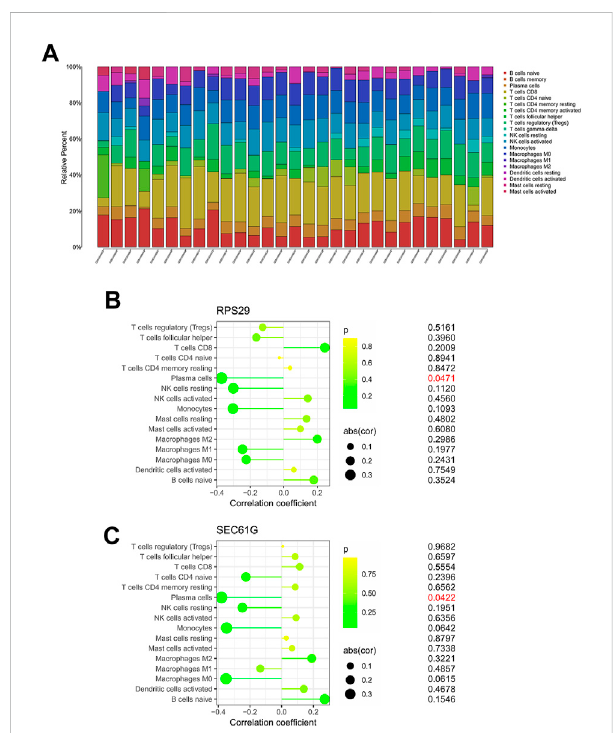
FIGURE 7 Analysis of immune in fi ltration between NC and RA sample. (A) Figure A represents the proportion of different immune cells in different samples. (B,C) represents the correlation between key genes RPS29 and SEC61G and immune cells,